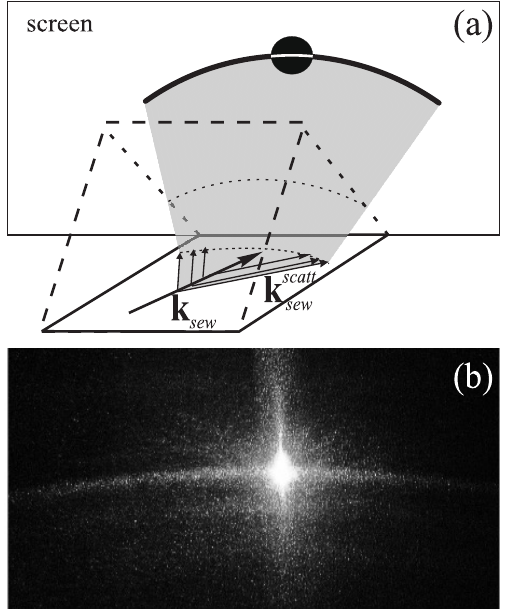
Figure 4. ( a ) Schematic describing the scattering of the BSWs in the plane of the propagation on the surface of the photonic crystal in the Kretschmann configuration; k SEW is the wave vector of the BSW, and k scatt is the wave vector of the scattered component of the BSW. ( b ) Scattering pattern of surface SEW electromagnetic waves in the total reflection direction. Reprinted from V.V. Moskalenko, I.V. Soboleva,